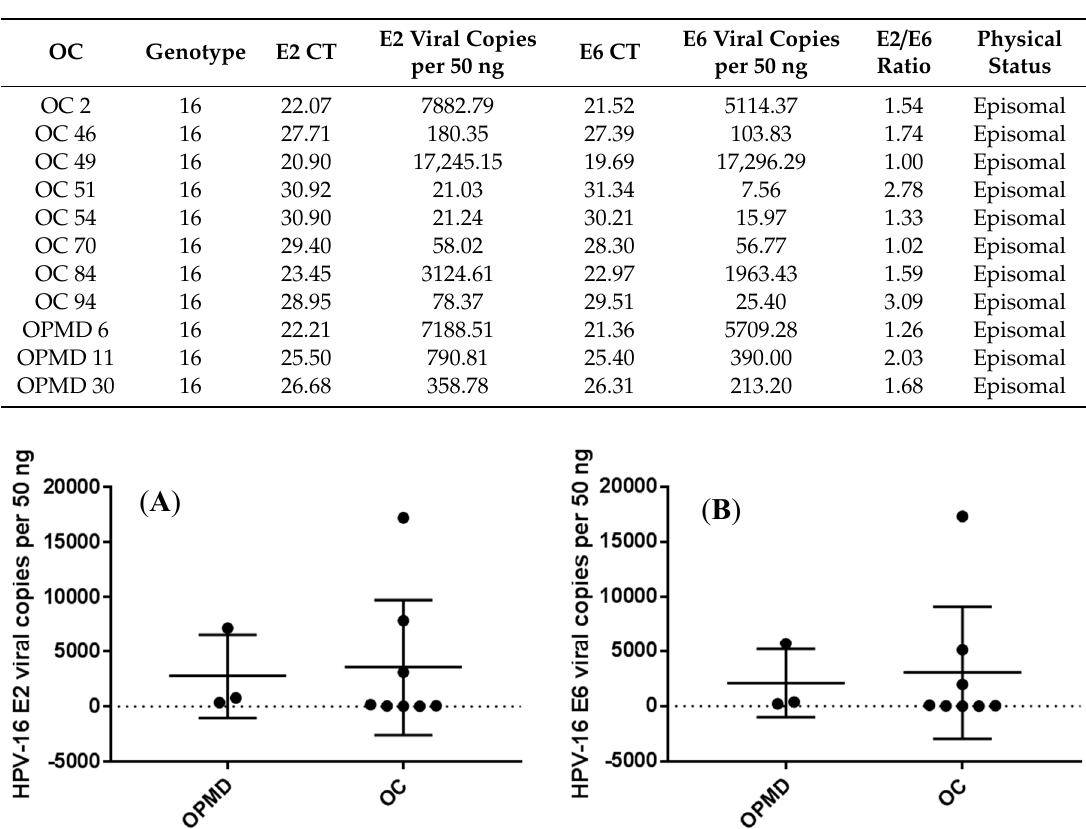
Table 3. Salivary HPV16 viral load and viral physical status in oral potentially malignant disorder (OPMD) and oral cavity carcinoma (OC) patients.